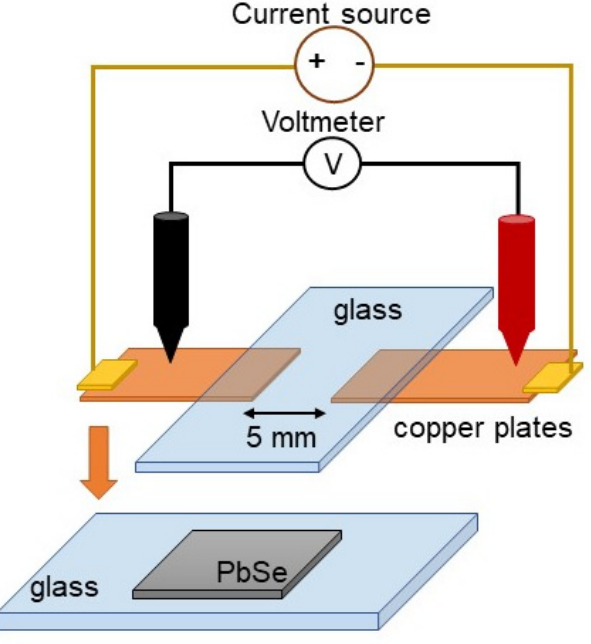
Measurements of the samples’ electrical characteristics were carried out on the laser- treated and untreated sample areas. Figure 2 schematically shows the setup for measuring the film’s electrical characteristics.